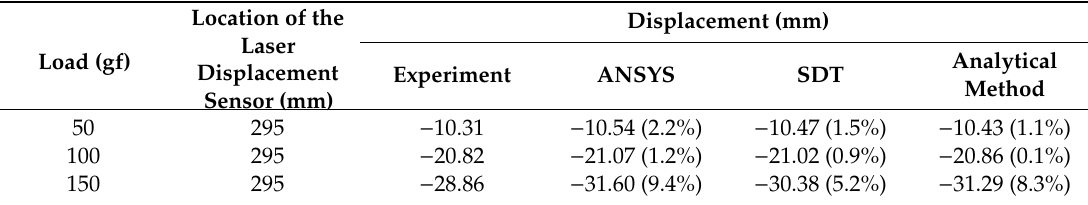
Table 3. Displacement estimation results using the SDT matrix (Single material).